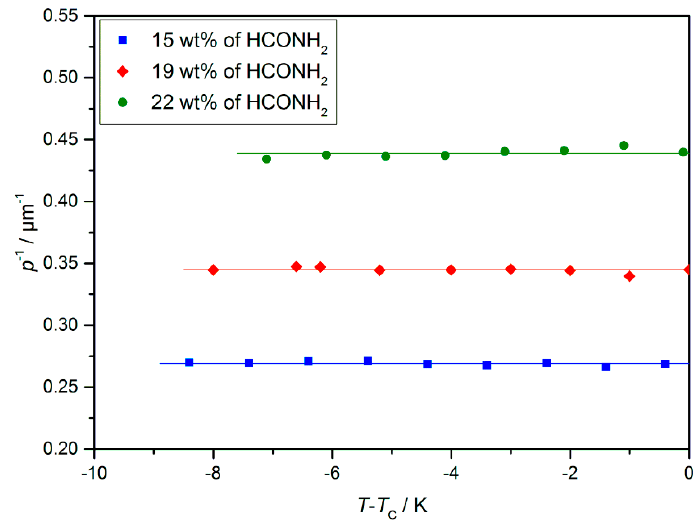
Figure 13. Helical twist p − 1 of the lyo-SmC* phase for different mass fractions of formamide measured by the Cano method [34]. While a strong increase of the twist was measured with increasing solvent content, no temperature dependence was observed. Most likely, the latter is due to a pinning effect between liquid crystalline phase and the glass surfaces of the measurement set up. (Reprinted by permission from Springer Nature: [13].)